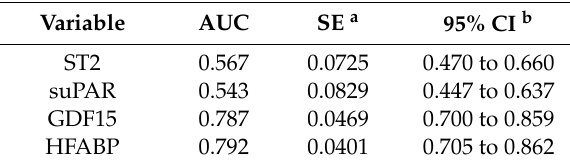
Figure 2. Receiver operating curve. Table 4. AUC-Analysis.